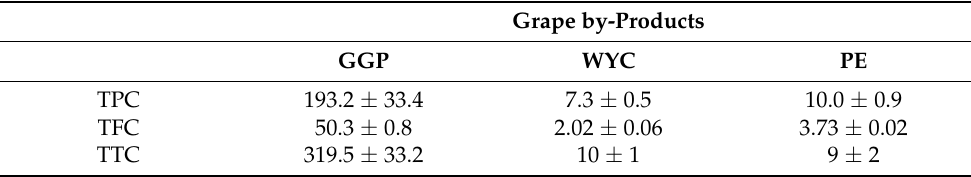
Table 5. Total Phenolic/Flavonoid/Tannin Content of grape by-products used in broilers’ diets. Grape by-Products